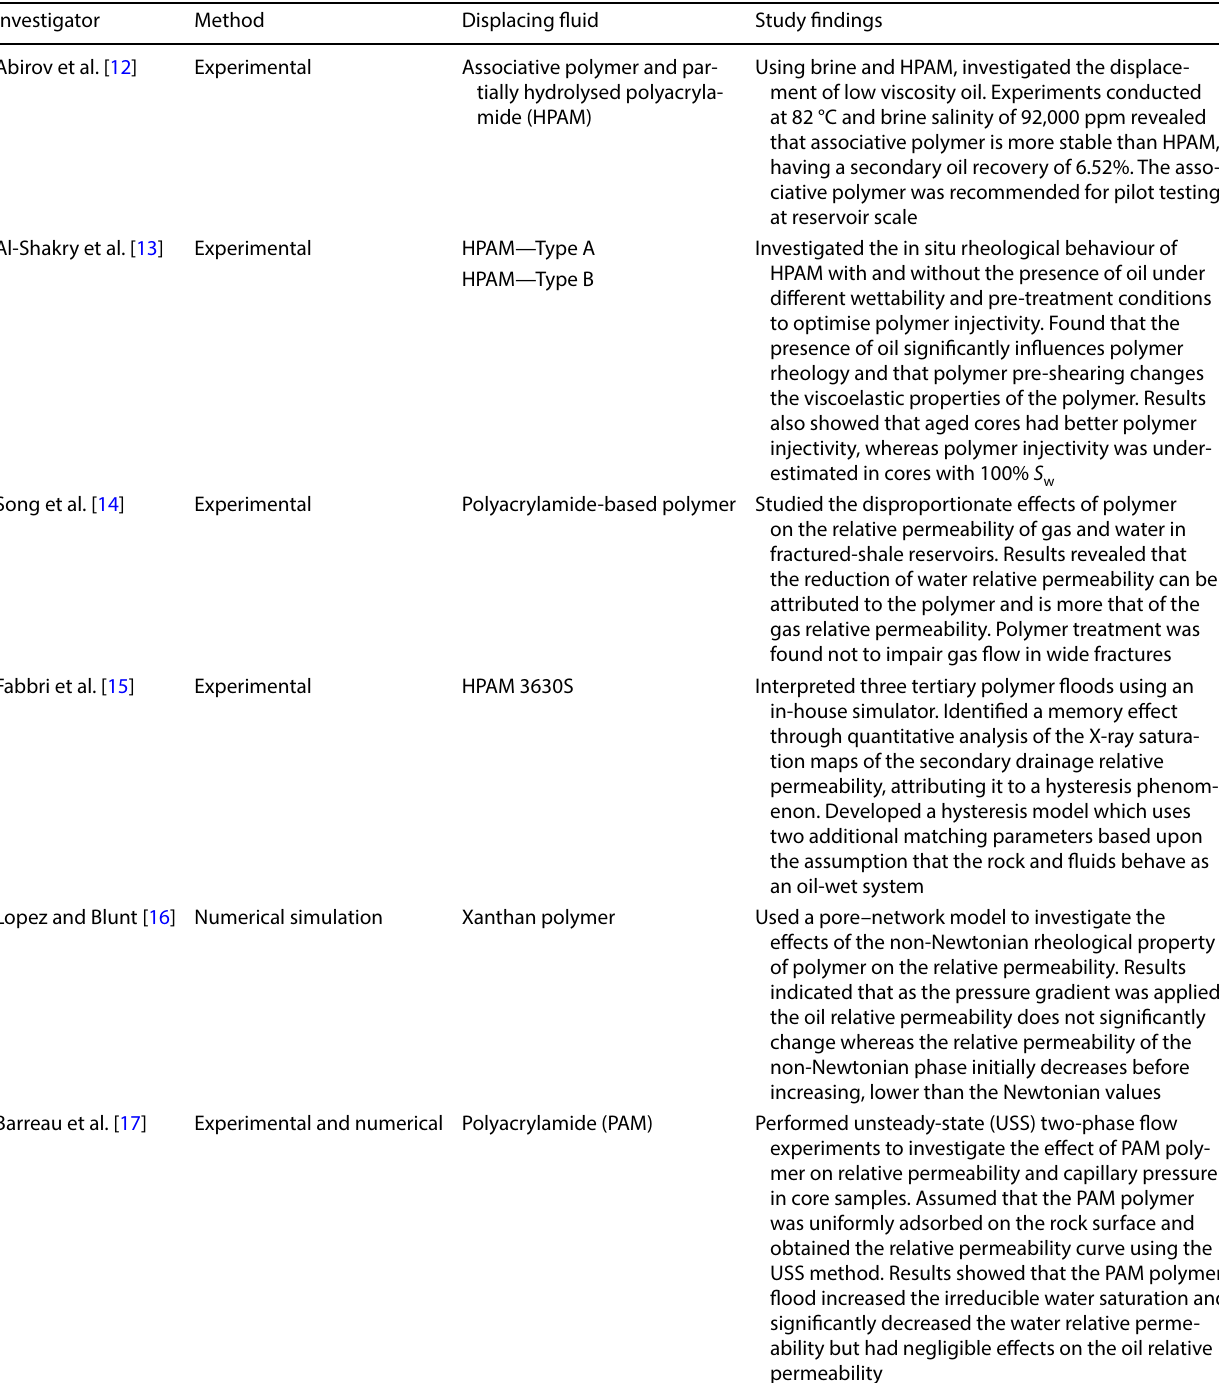
Table 1 Studies of polymer